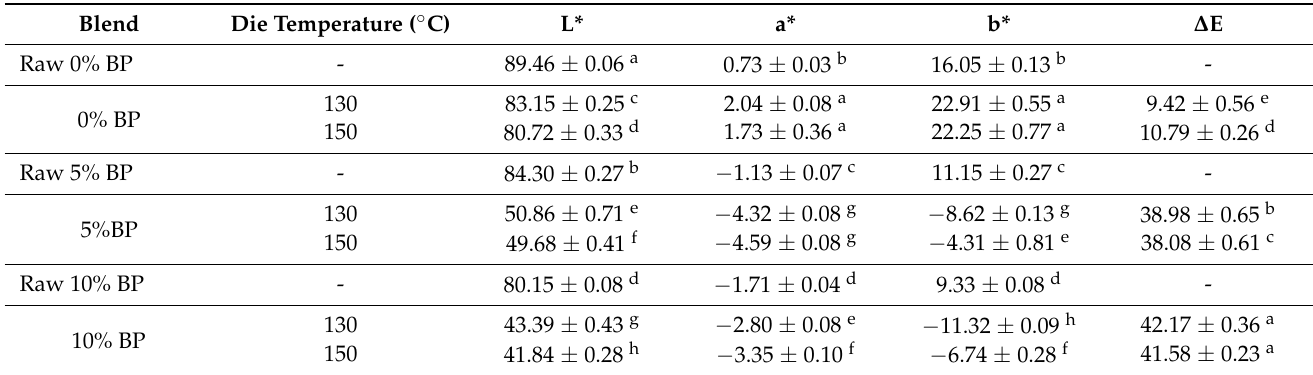
Table 3. Color parameters (mean ± standard deviation) of extrudates as a function of extrusion die temperature and butterfly pea flower (BP) concentration. Values in the same column followed by same letters are not significantly ( p < 0.05) different ( n = 2 for extrusion and n = 3 for color